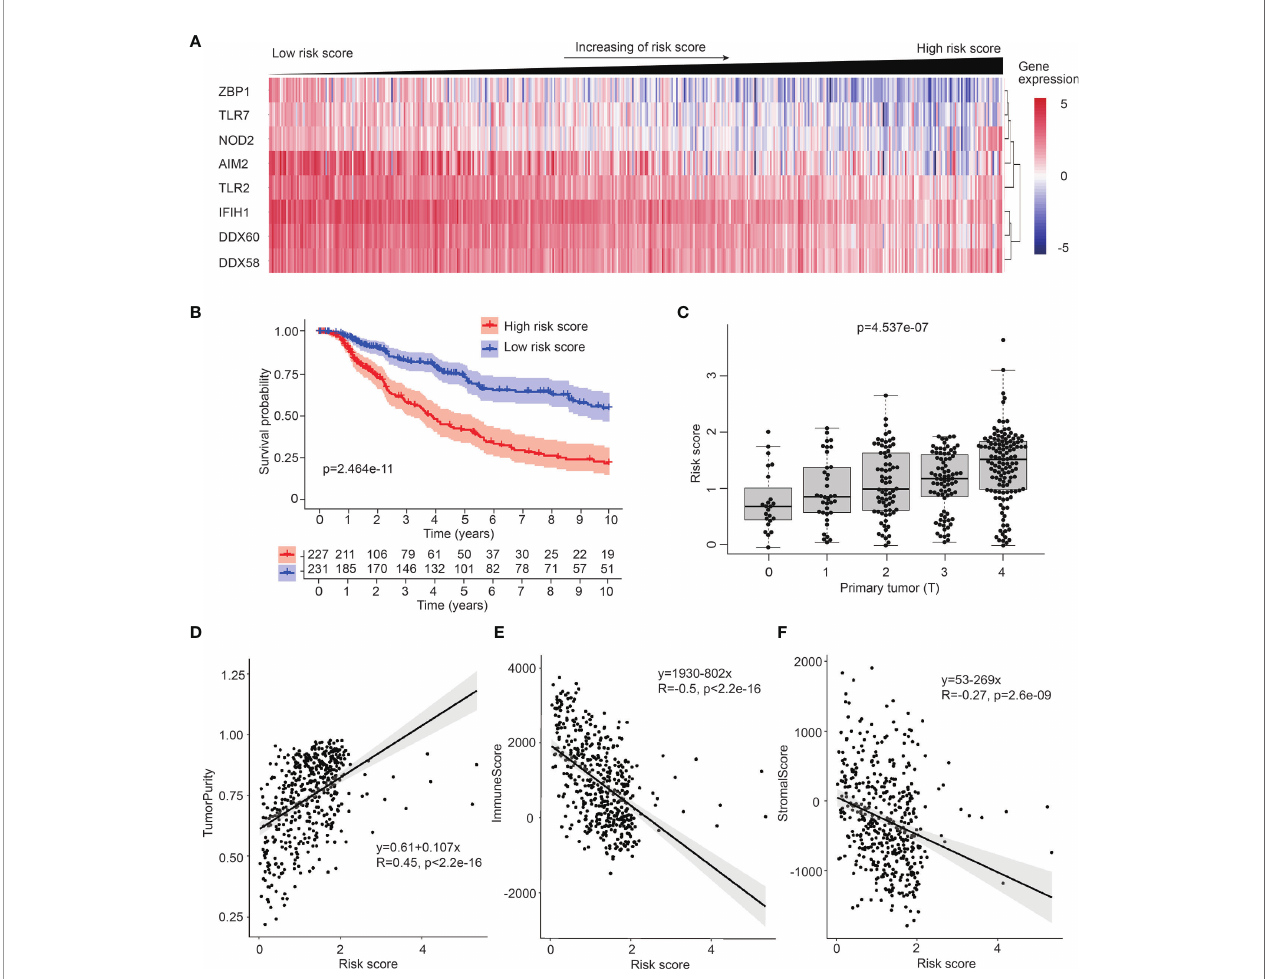
FIGURE 2 | Establish of PRR-based prognosis model in SKCM. (A) Heatmap of 8 PRR molecules ’ expression used in the prognosis model in 468 SKCM patients ranked by their risk score. (B) Survival curve of low risk score group and high risk score group of SKCM patients, samples which no data of survival times are fi ltered out. (C) Risk score is high-positive correlated to primary tumor (T). (D) ESTIMATE analysis shows risk score is positive-correlated to tumor purity (R=0.45). (E) ESTIMATE analysis shows risk score is negative-correlated to immune score in SKCM (R=-0.5). (F) ESTIMATE analysis shows risk score is negative-correlated to stromal score in SKCM (R=-0.27)